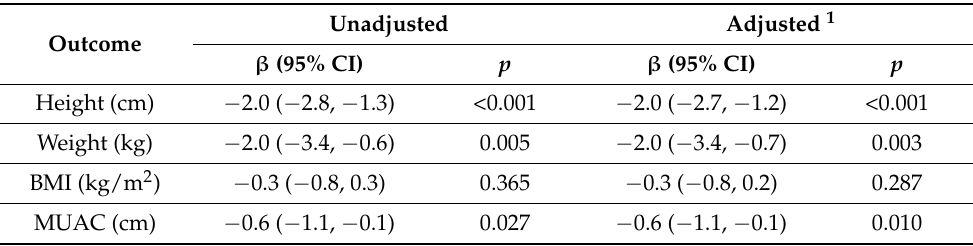
Table 2. Association of household food insecurity with nutritional status among early-gestation pregnant women in Matlab.